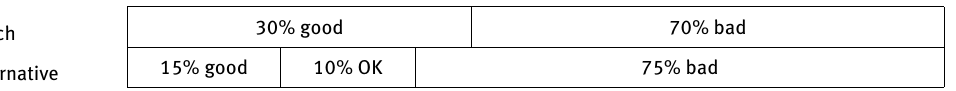
Fig. 3: Polarized distribution of Dutch sailors; “semi-polarized” distribution of int’l sailors